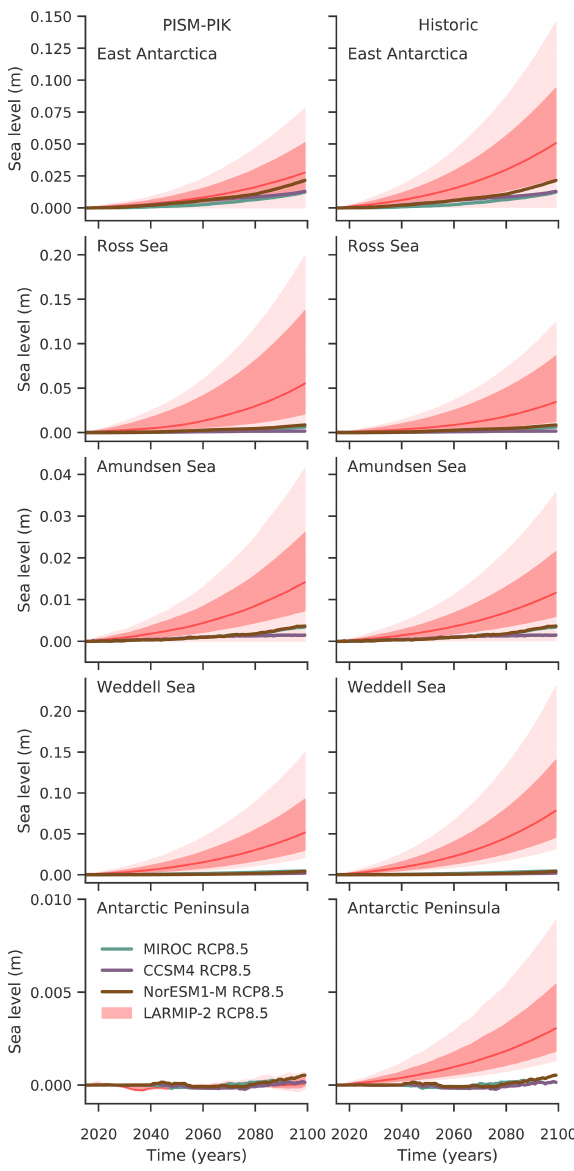
Figure 5. Projections of Antarctica’s sea level contribution under the RCP8.5 climate scenario for the different Antarctic regions for LARMIP-2 and for the ISMIP6 experiments driven by NorESM1- M, MIROC and CCSM4 ocean forcing. The very likely ranges (5th to 95th percentiles, light red shading), likely ranges (percentiles 16 . 6 to 83 . 3, dark red shading) and the respective median (50th per- centile, red lines) of mass loss are shown for (left panels) the PISM- PIK simulations submitted to LARMIP-2 (Levermann et al., 2020) and for comparison (right panels) estimated following LARMIP-2 for the setup as submitted to